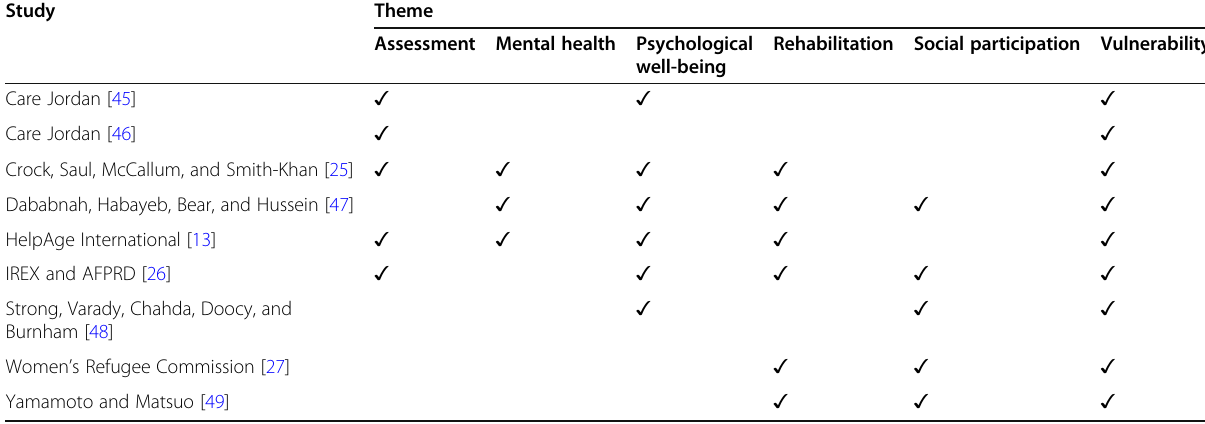
Table 2 Concept matrix of identified themes